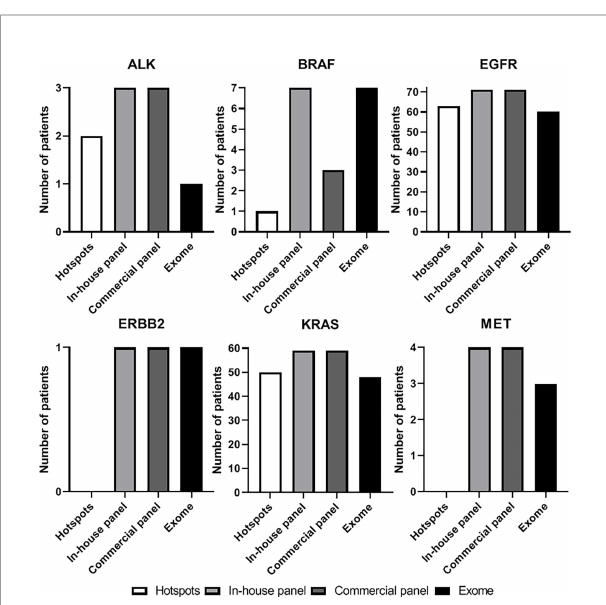
FIGURE 1 | Number of patients with a mutation found on ALK , BRAF , EGFR , ERBB2 , KRAS and MET genes according on the technic used: hotspot analysis (white), in-house panel (light grey), commercial panel (dark grey), or exome analysis